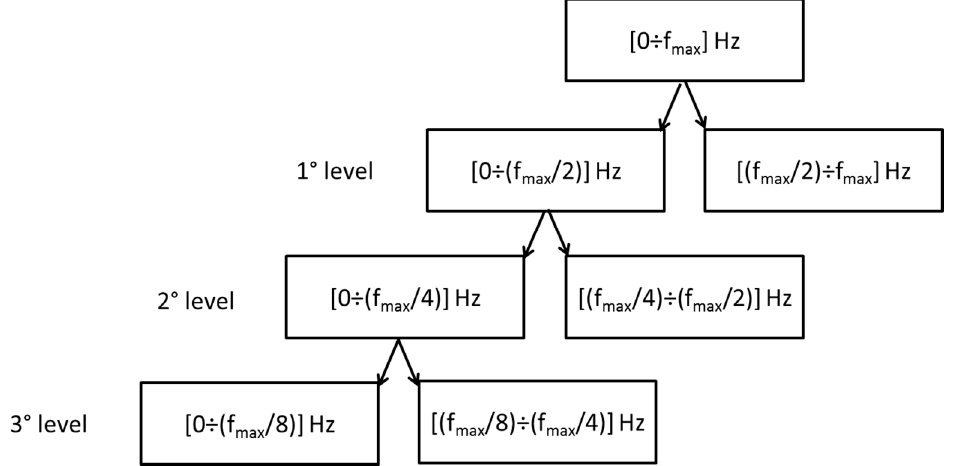
Figure 2. Discrete wavelet transform (DWT) decomposition scheme.